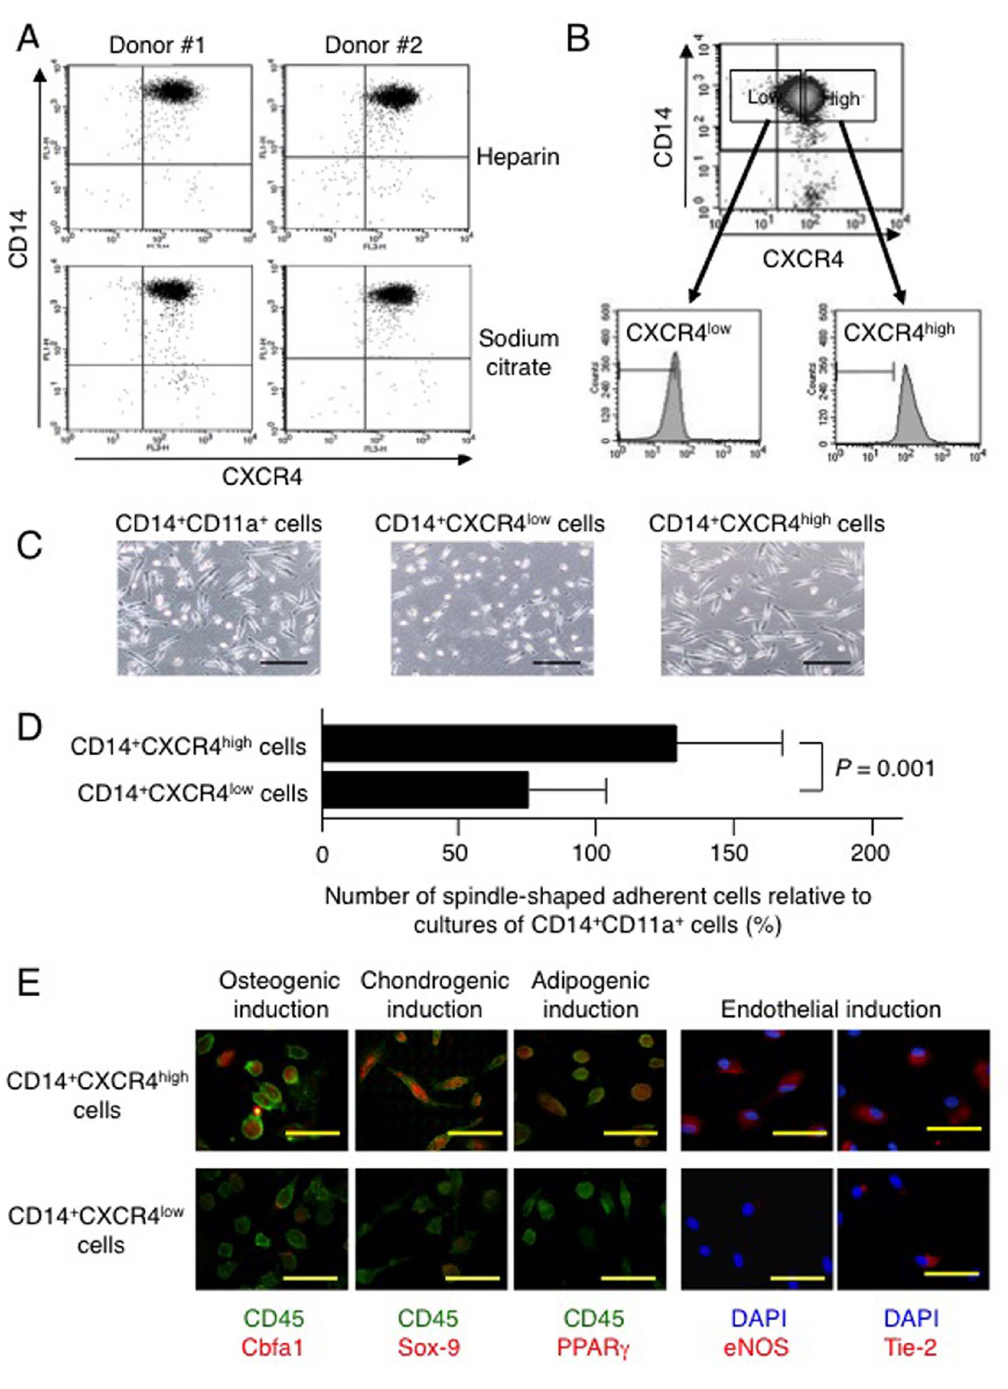
Figure 6. MOMC precursors are enriched in CD14 + CXCR4 high cells. ( A ) Dot-plot analysis of expression of CD14 and CXCR4 in CD14 + monocytes derived from 2 independent donors. Peripheral blood samples were anticoagulated with heparin or sodium citrate immediately after blood sampling. ( B ) Dot-plot analysis of CXCR4 expression in CD14 + cells, gated by CXCR4 high and CXCR4 low cells for fluorescent-activated cell sorting. Cell-surface CXCR4 on CXCR4 high and CXCR4 low cells is shown as histograms. ( C ) Morphology of adherent cells obtained from CD14 + CD11a + , CD14 + CXCR4 high , or CD14 + CXCR4 low cells cultured on fibronectin with platelet-conditioned medium. Bars: 200 m m. ( D ) The generation of spindle- shaped adherent cells, expressed as a proportion (%) of those generated by culturing CD14 + CD11a + cells. Results show the mean and SD of three independent experiments. ( F ) Multidifferentiation potential of cells obtained by culturing CD14 + CXCR4 high and CD14 + CXCR4 low cells. Cells treated for osteogenic, chondrogenic, adipogenic, and endothelial induction for 1 week were analyzed by immunohistochemical staining for Cbfa1, Sox-9, or PPAR c (red) in combination with CD45 (green), or for eNOS or Tie-2 (red) in combination with DAPI (blue), and were observed under a fluorescence microscope. Representative results of 3 independent experiments are shown. Bars: 50 m m.